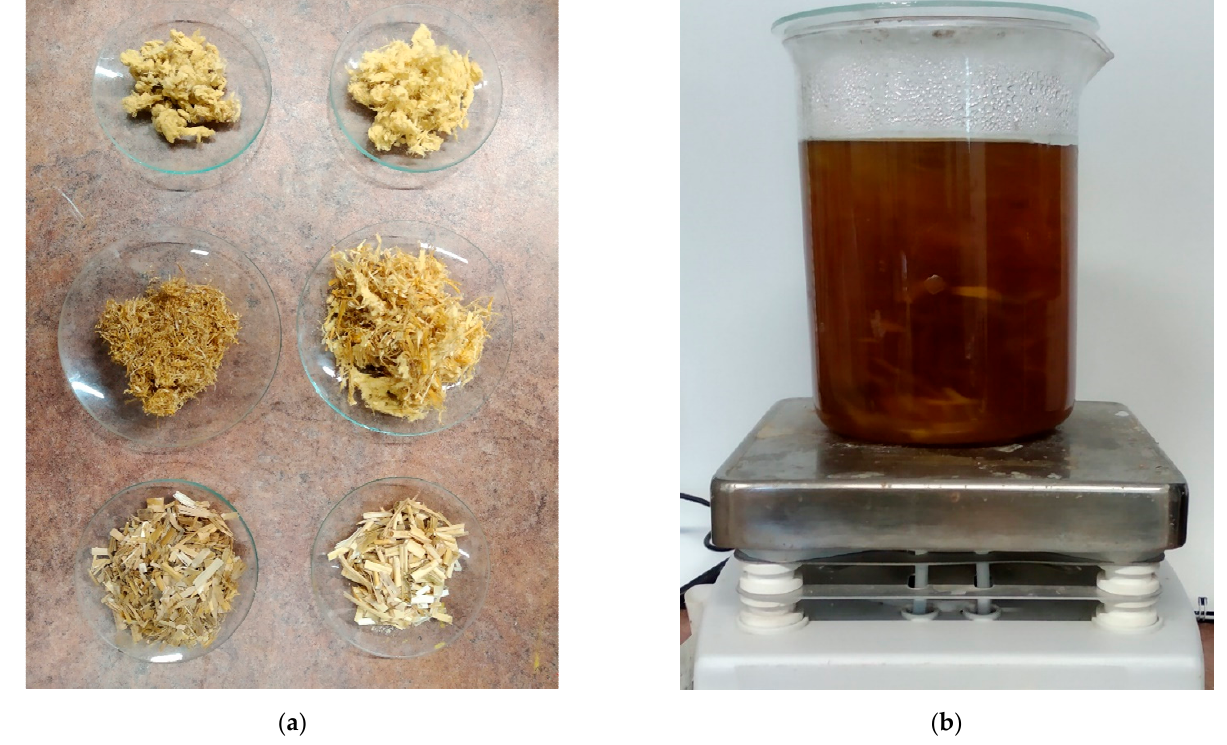
Figure 5. ( a ) Experimental determination of cellulose content, left column is Type-1, and the right column is Type-2 straw, from bottom to top: chopped raw straw, mixed fibers, residual fibers containing almost only clear cellulose; ( b ) separation of cellulose from other materials in NaOH solution.